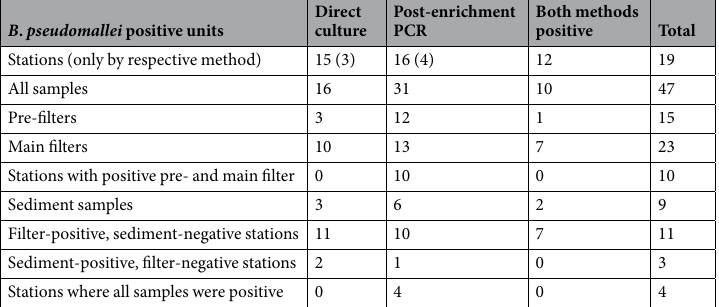
Table 2. Number of B . pseudomallei positive units comparing different detection methods and sample types (pre-filters, main filters,